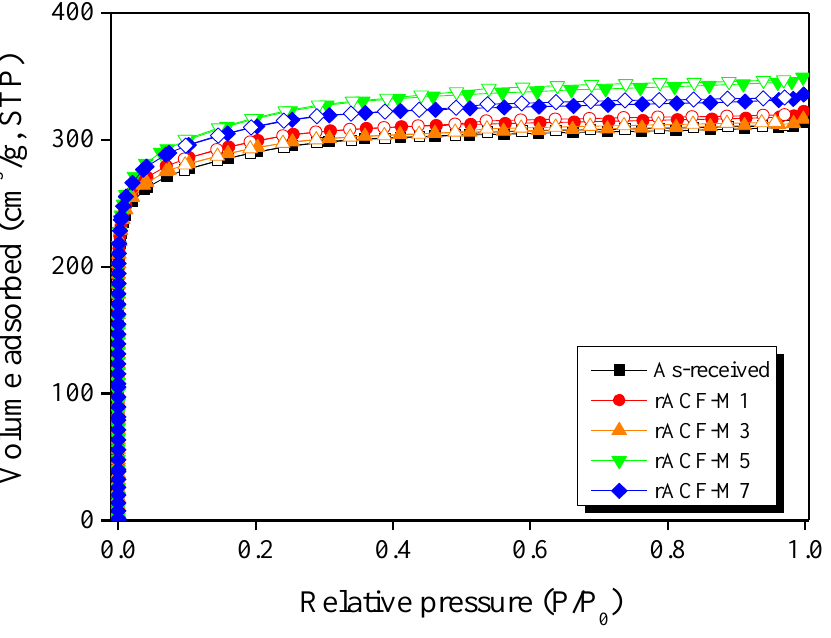
Figure 4. N 2 /77K adsorption–desorption isotherm of activated carbon fibers according to the microwave heating time. Table 2. Textural Properties of Activated Carbon Fibers according to the Microwave Heating Time.